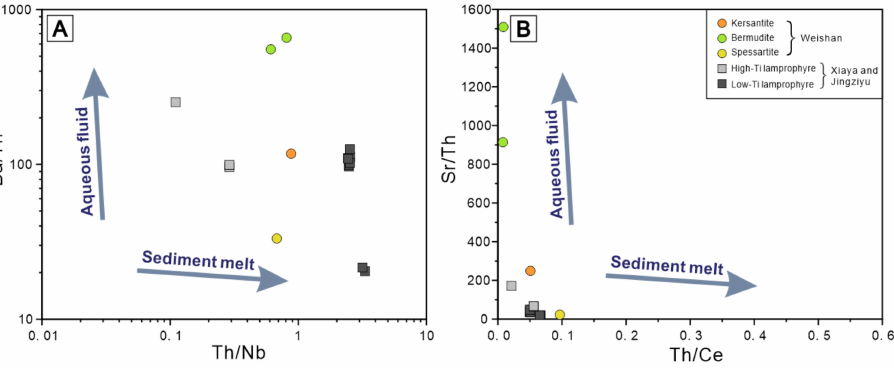
Figure 13. ( A ) Ba/Th vs. Th/Nb diagram [53]. ( B ) Sr/Th vs. Th/Ce diagram [74].